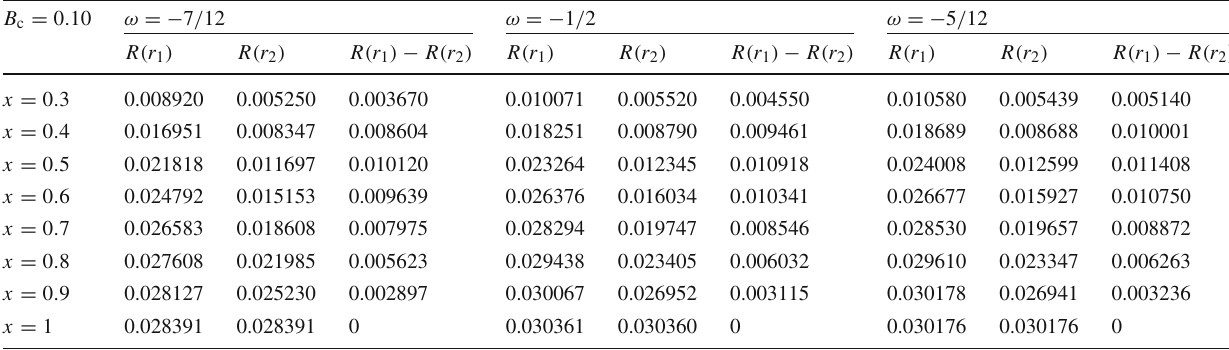
Table 3 The Ruppeiner curvature scalar for different ω with B c = 0 . 10